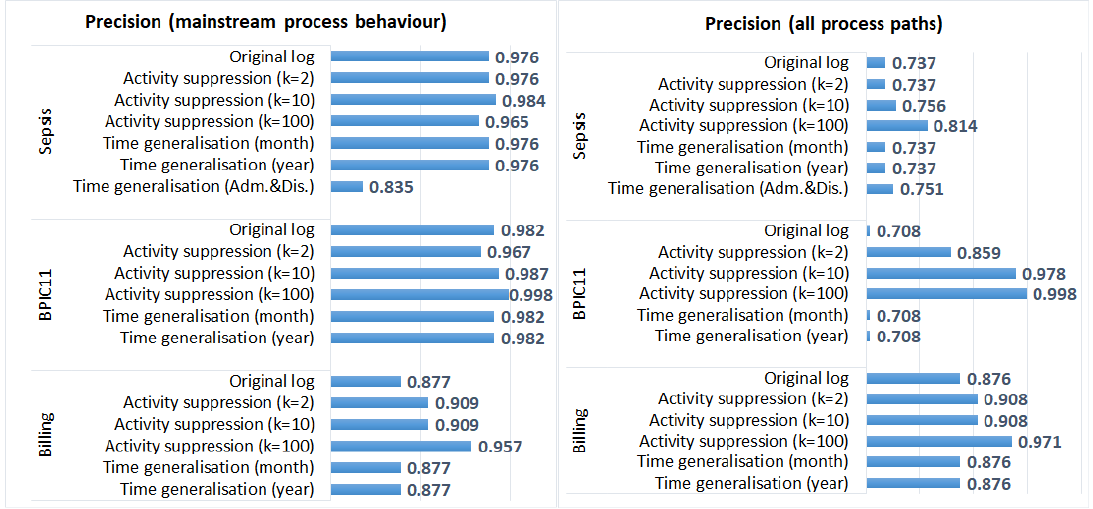
Figure 4. The impact of activity suppression and time generalisation on the results of process discovery: precision values for the three event